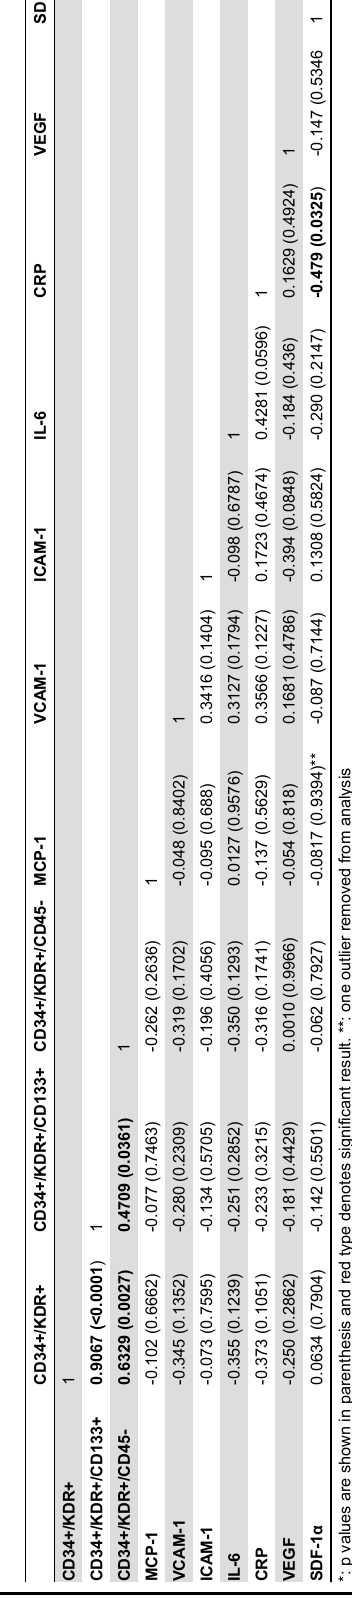
Table 4. Characteristics of 20 Subjects, CVD Biomarkers, CEPC Count, and Vascular Injury